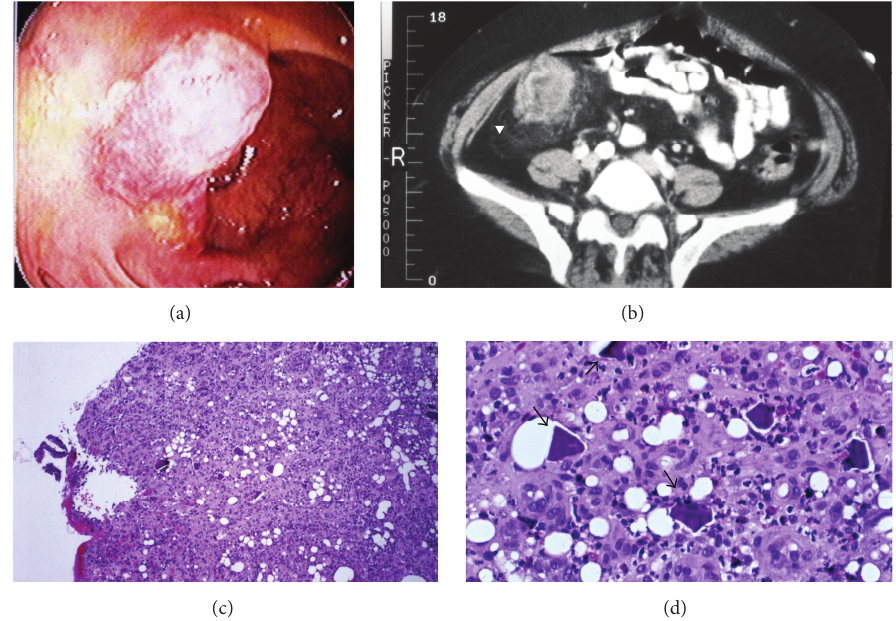
Figure 1: (a) A mass visualized in the cecum by colonoscopy. (b) Computed tomography of the abdomen (axial view) with a 5-cm mass identified in the right-lower abdominal area (white arrowhead). (c) Microscopic examination shows mucosal inflammation and presence of inclusion crystals (hematoxylin-eosin stain) ( × 100). (d) Sodium polystyrene sulfonate crystals (black arrows) surrounded by inflammatory cells (hematoxylin-eosin stain) ( × 400).